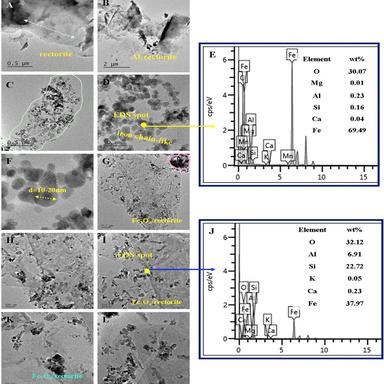
TEM photograph of samples.